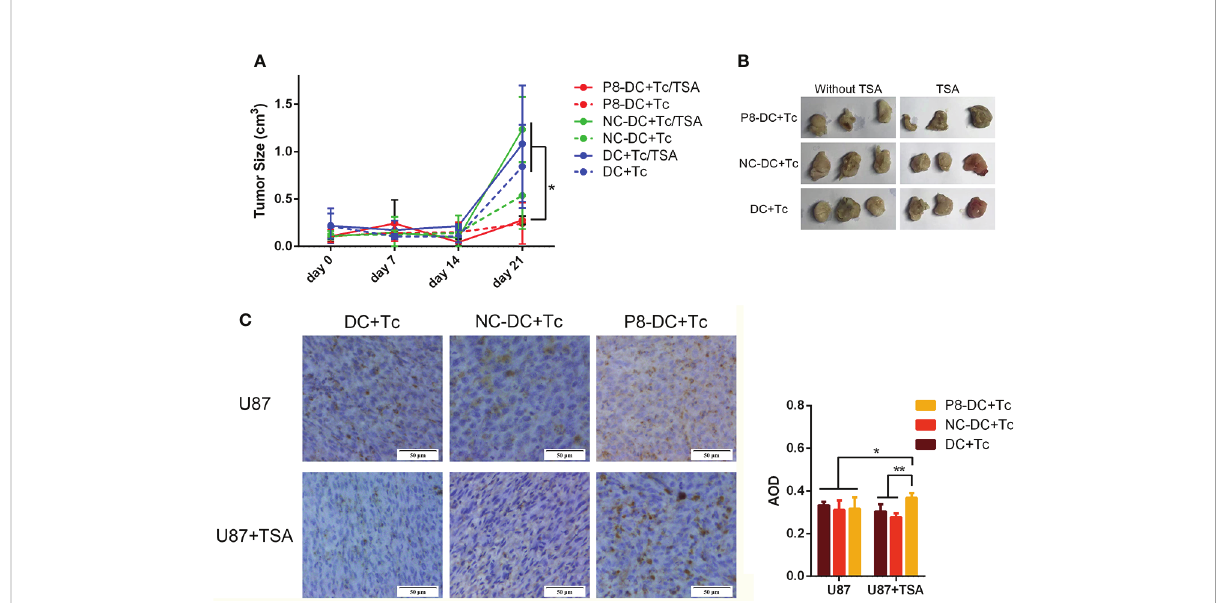
FIGURE 7 P8-speci fi c T cells inhibited the in vivo growth of U87 cell-derived tumors. (A) Tumor growth was suppressed by the adoptive transfer of P8- speci fi c T cells. (B) Tumors harvested from mice that were inoculated with different groups of T cells and glioma cells. (C) CD8 + T cells in fi ltrated glioma tissue in vivo . DC, dendritic cell; Tc, T cell; NC, negative control peptide. *P <0.05, **P <0.01, scale bar: 50 m